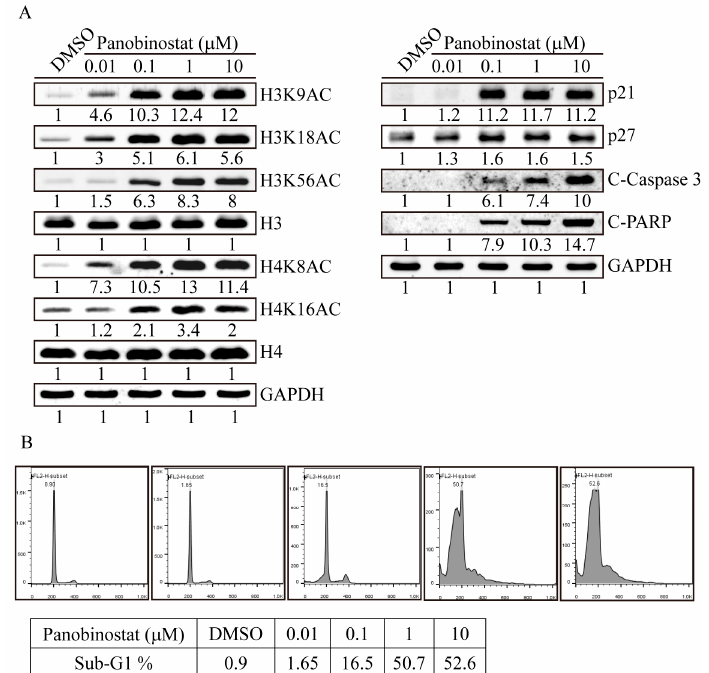
Figure 3. Panobinostat dose-dependently induced histone acetylation and apoptosis-related protein expression in SW579 cells. ( A ) Cell lysates from SW579 cells treated with different concentrations (0.01 to 10 µM) of panobinostat for 6 h were immunoblotted with different H3 (H3K9AC, H3K18AC and H3K56AC) and H4 (H4K8AC and H4K16AC) histone acetylation antibodies. Cell lysates of SW579 cells treated with panobinostat for 24 h were analyzed for cell cycle (p21 and p27) and apoptotic-related (C-caspase 3: cleaved caspase 3 and C-PARP: cleaved PARP) protein expression. The H3, H4 and GAPDH immunoblots served as internal controls. Densitometric analysis of all western-blot was performed by ImageJ software. The protein expressions were normalized with their internal control such as H3, H4 or GAPDH expressions and shown as fold of control. ( B ) Cell cycle analysis of dose-dependent panobinostat treatments from 0.01 to 10 µM on SW579 cells by flow cytometry. Apoptotic cells were determined by the sub-G1 cell population.